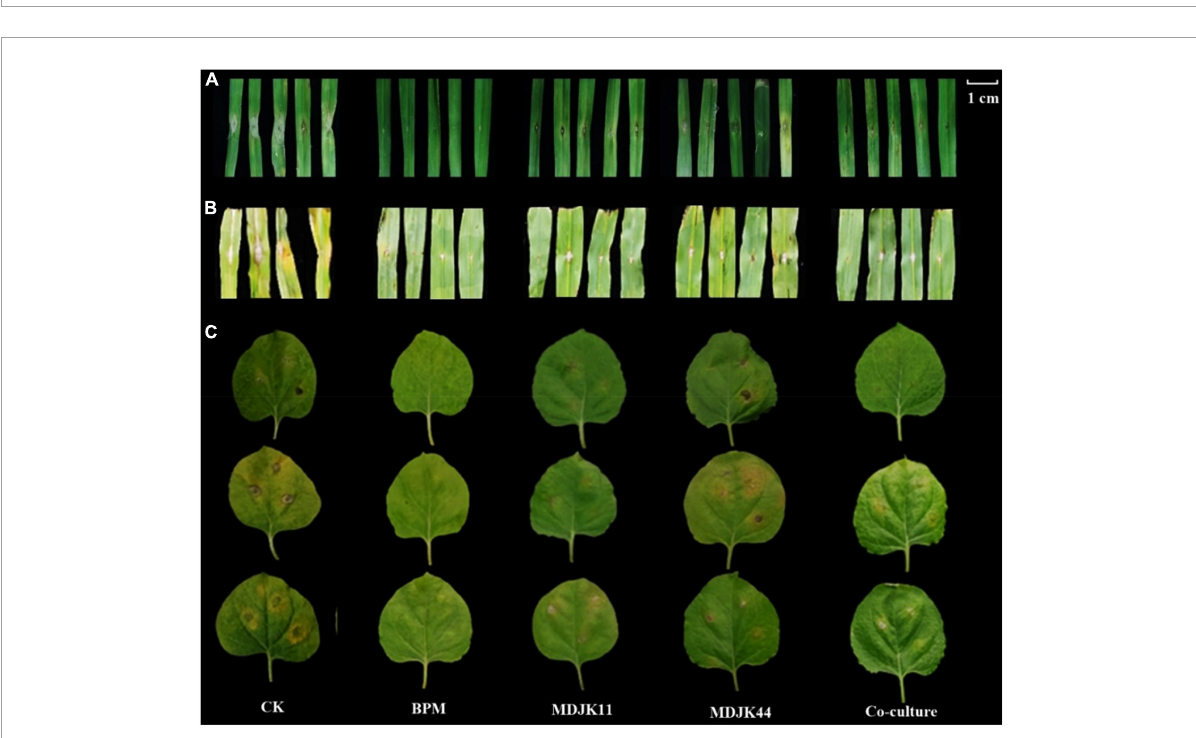
FIGURE6 Effect of Streptomyces MDJK44, MDJK11 monoculture, and co-culture in BF4 medium fermentation broth crude extract on different plant diseases infected by pathogenic fungi for 5 days [ (A) , wheat infected with Fusarium graminearum ; (B) , maize infected with Fusarium oxysporum ; (C) , tobacco infected with Fusarium moniliforme